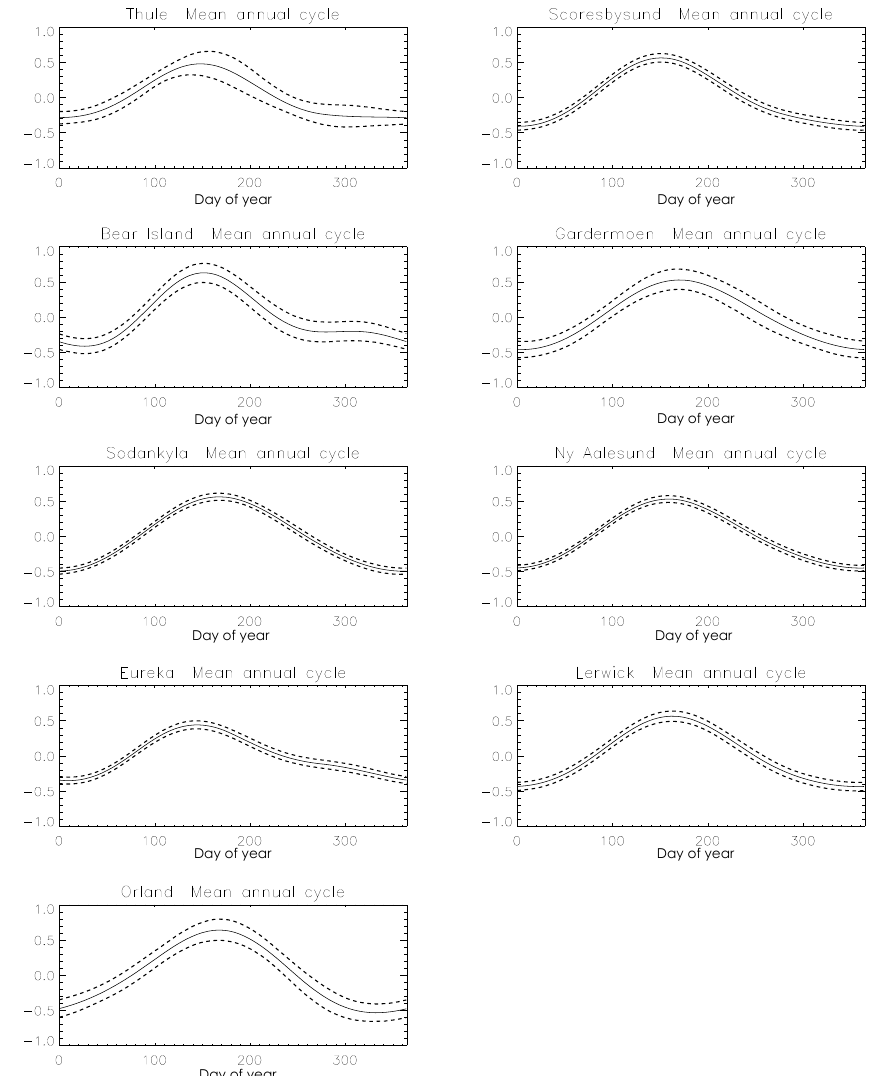
Figure 8. The annual cycle as a function of day of year at 500hPa. The full curve shows the posterior mean; dashed curves indicate the 95% confidence intervals for each day of the year. Model settings: n pol = 4, n cyc = 2, n 1 tr = n θ tr = 0 and white